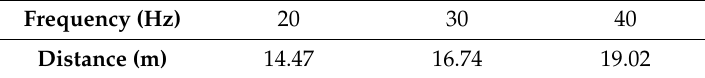
Table 4. Distance covered when the coating was worn off.